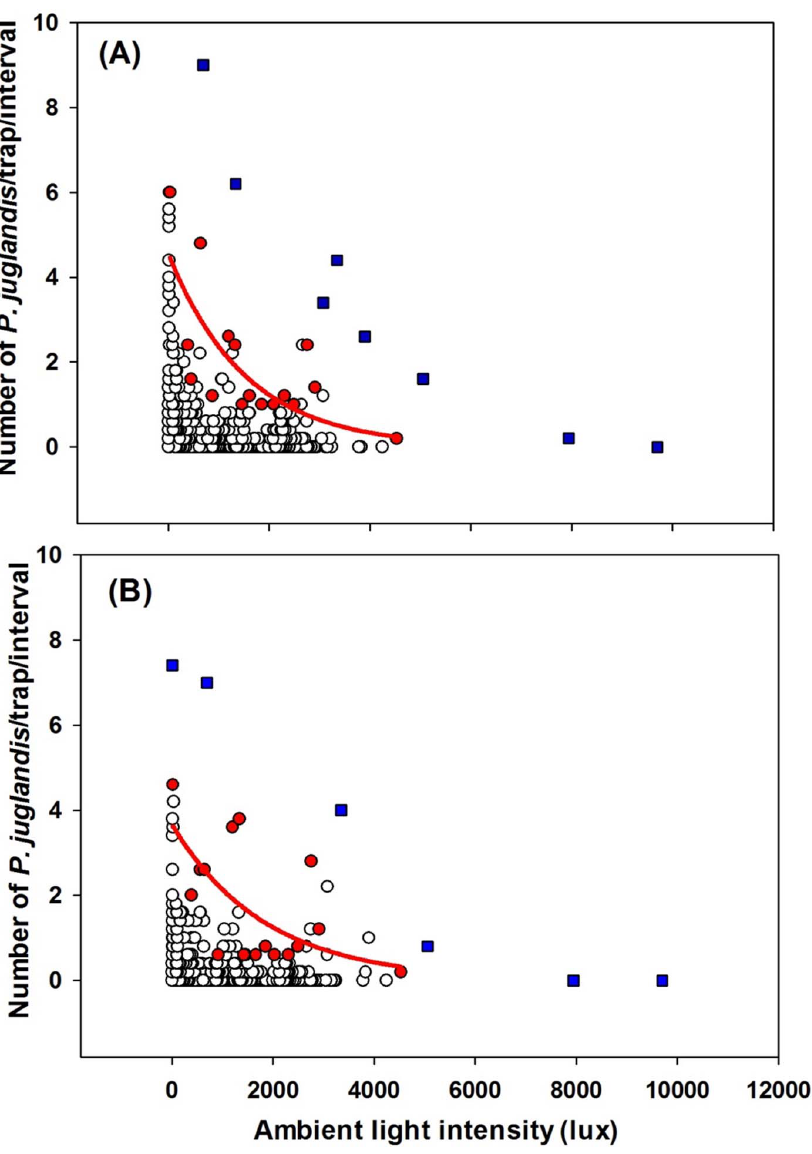
Figure 5. The exponential decay relationship ( Y = a 6 exp ( 2 bX )) between Pityophthorusjuglandis catches and light intensity (lux). (A) Female: N =856, F =14.90, P , 0.01, a =4.56, b =0.0007, adj. R 2 =0.48; (B) Male: N =856, F =8.31, P , 0.05, a =3.67, b =0.0005, adj. R 2 =0.33. Blue % : Outliers; Red q : Data points used to fit curves. These points were the greatest values of trap catches from each of the light intensity classes [28].